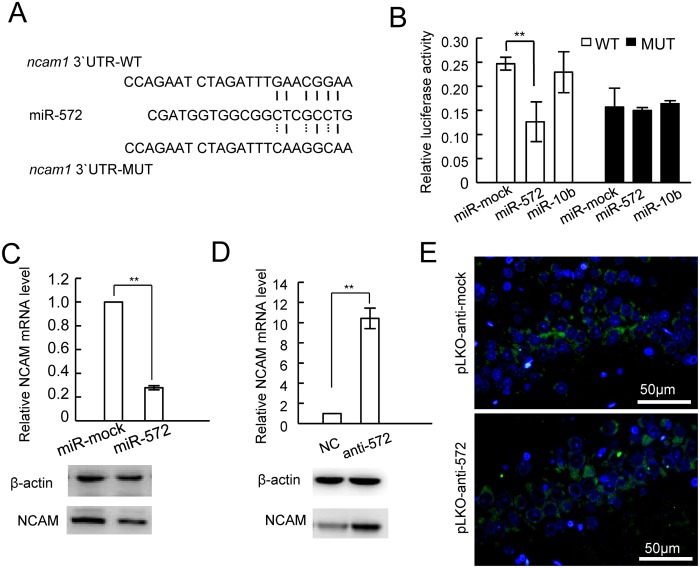
Targeted regulation of the expression of NCAM by miR-572.A. Schematics of miR-572 binding to the 3'UTR region of the NCAM1 mRNA (wildtype and mutant) in the dual-luciferase experiment. B. The dual-luciferase assay showed that miR-572 significantly reduced the luciferase activity of plasmids containing the wildtype 3'UTR region of mouse NCAM1 mRNA. C. Overexpression of miR-572 in mouse HT22 cells could significantly reduce the NCAM1 expression at the mRNA and protein levels. D. Inhibition of miR-572 in mouse HT22 cells could significantly promote NCAM1 expression at the mRNA and protein levels. E. Immunohistochemical detection showed that after inhibiting miR-572 expression in the POCD rat brain, the NCAM1 expression was elevated. WT, wildtype; MUT, mutant; NC, negative control.